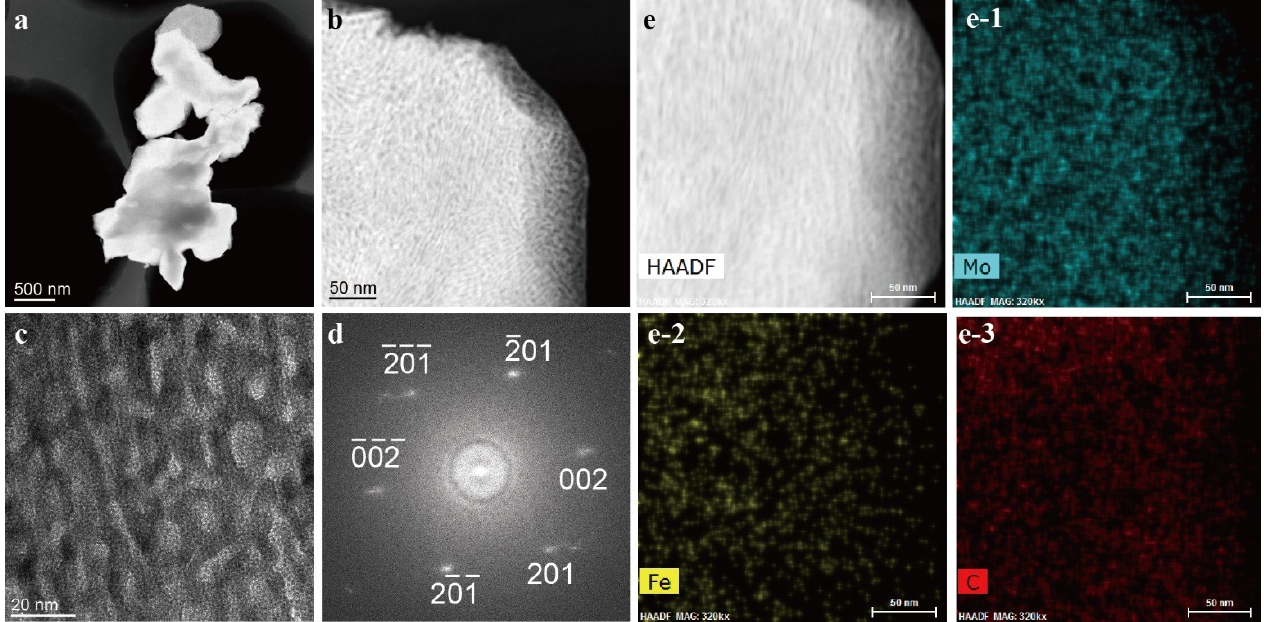
Figure 7. ( a , b ) STEM-HAADF image, ( c , d ) high-resolution TEM (HRTEM) image and its corresponding FFT image of spent 1.5Fe-Mo 2 C-550 catalyst, which show that its crystallinity and microstructure keep unchanged, ( e ) STEM-HAADF and its corresponding EDX element mapping of ( e - 1 ) Mo, ( e - 2 ) Fe, ( e - 3 ) C of spent catalyst 1.5Fe-Mo 2 C-550, indicating no aggregation of Fe species .